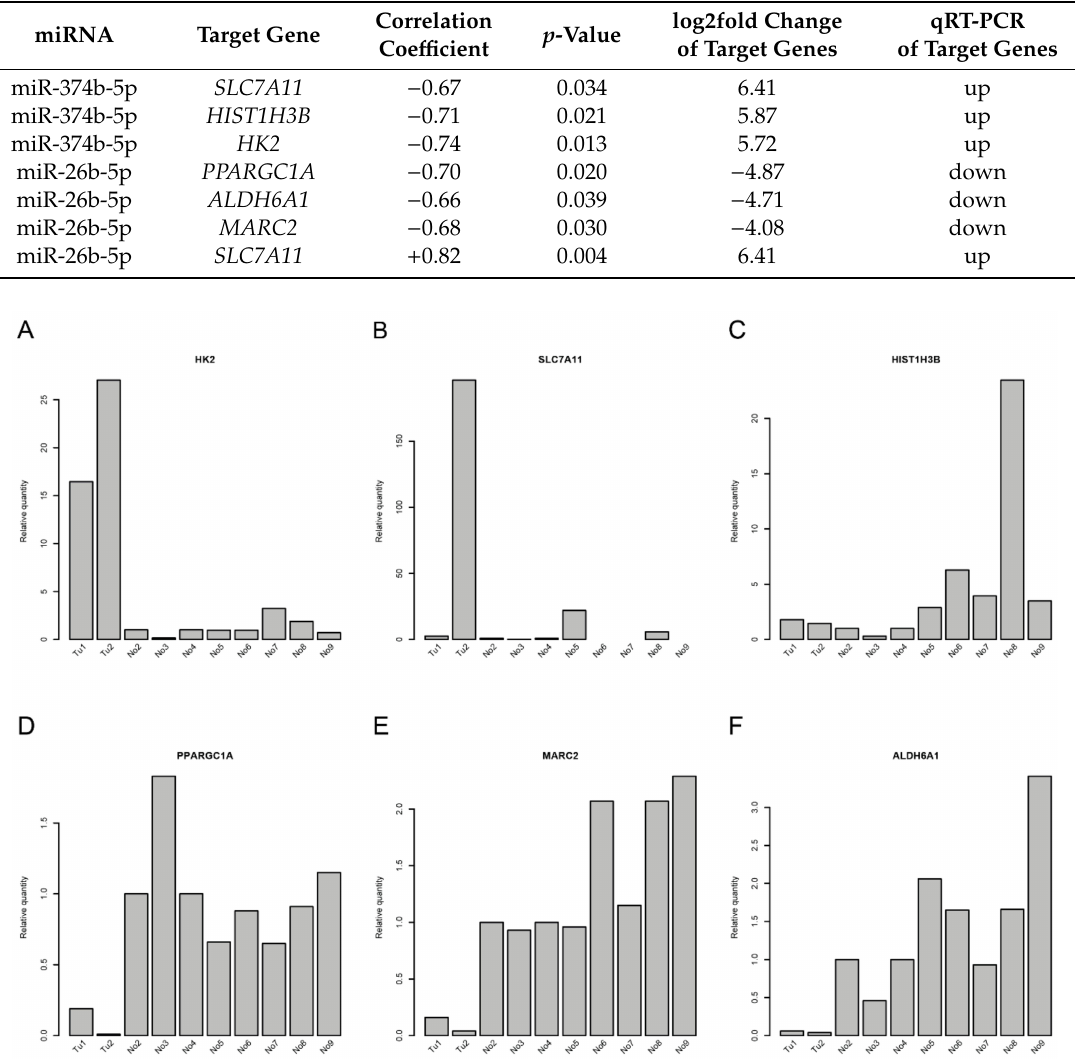
Figure 3. Quantitative RT-PCR for deregulated genes in collecting duct renal cell carcinoma (CDC). Gene expression of ( A ) HK2 , ( B ) SLC7A11 , ( C ) HIST1H3B , ( D ) PPARGC1A , ( E ) MARC2 , and ( F ) ALDH6A1